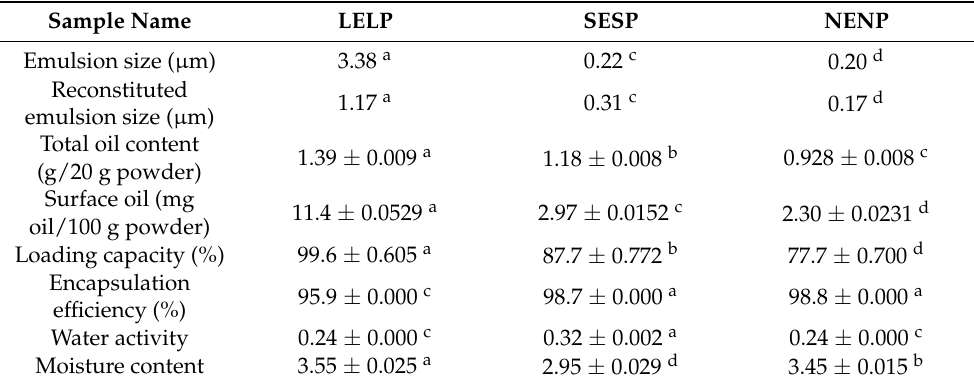
Table 1. Properties of spray-dried powders.